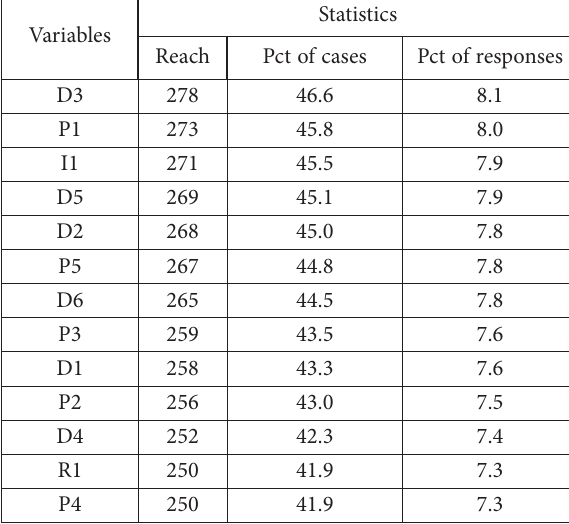
Table 5. Maximum group size of 1 (reach and